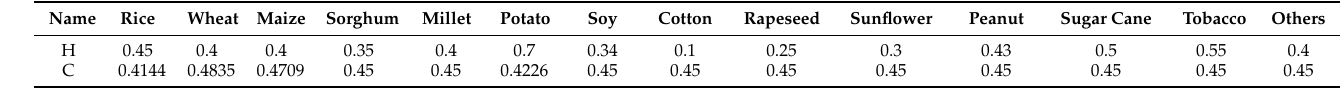
Table 3. Economic coefficient and carbon absorption ratio for main